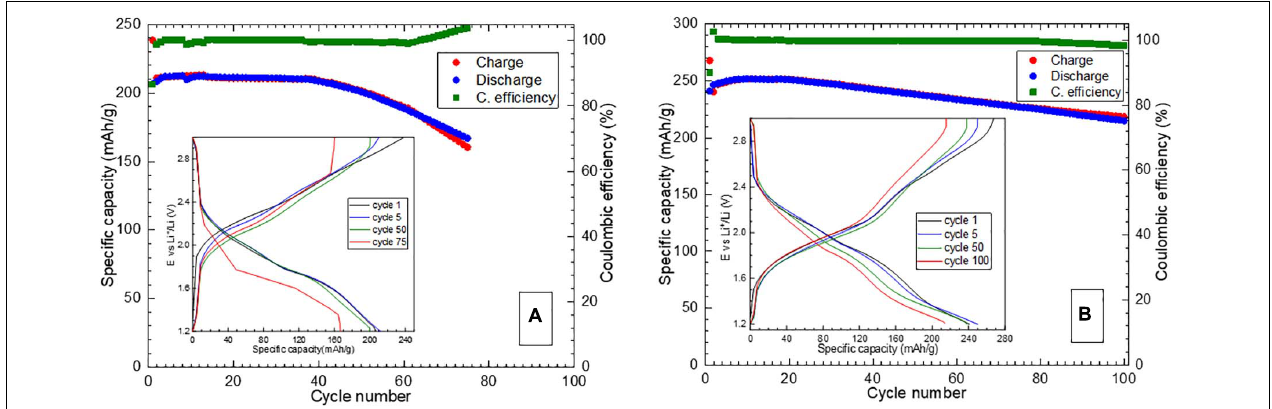
FIGURE 3 | Specific capacity and Coulombic efficiency results of long-term cycling of (A) Li 2 FeSO and (B) Li 2 Fe 0 . 9 Co 0 . 1 SO at 1C current density. Insets–selected galvanostatic charge/discharge curves.